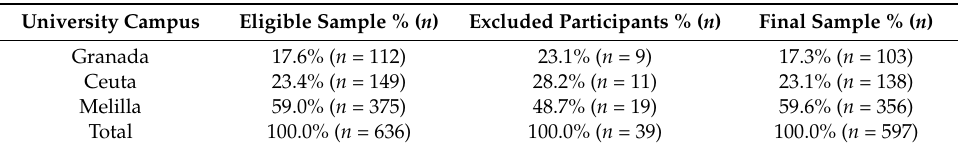
Table 1. Proportion of the sample (eligible sample, excluded participants, and final sample) attending the university campuses of Granada, Ceuta, and